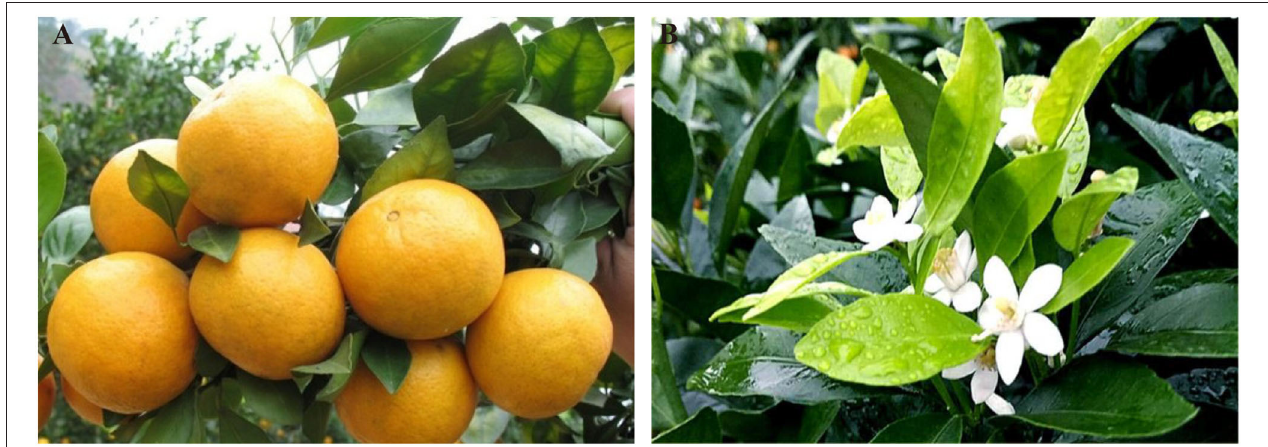
FIGURE 1 | The graph of the TC fruits and flowers. (A) The fruits of TC; (B) the flowers of TC.